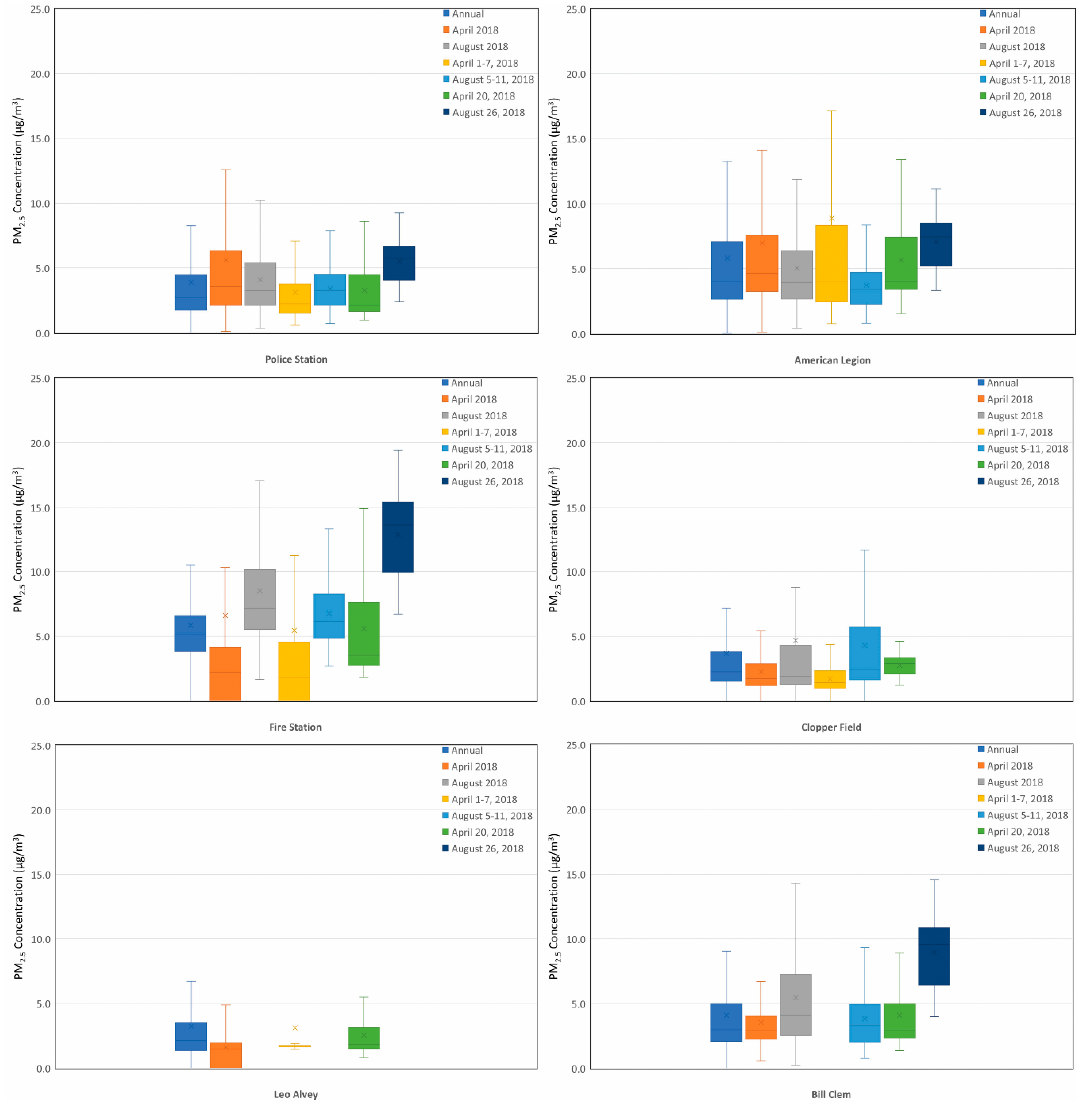
ff erent time periods: Annual (24 October